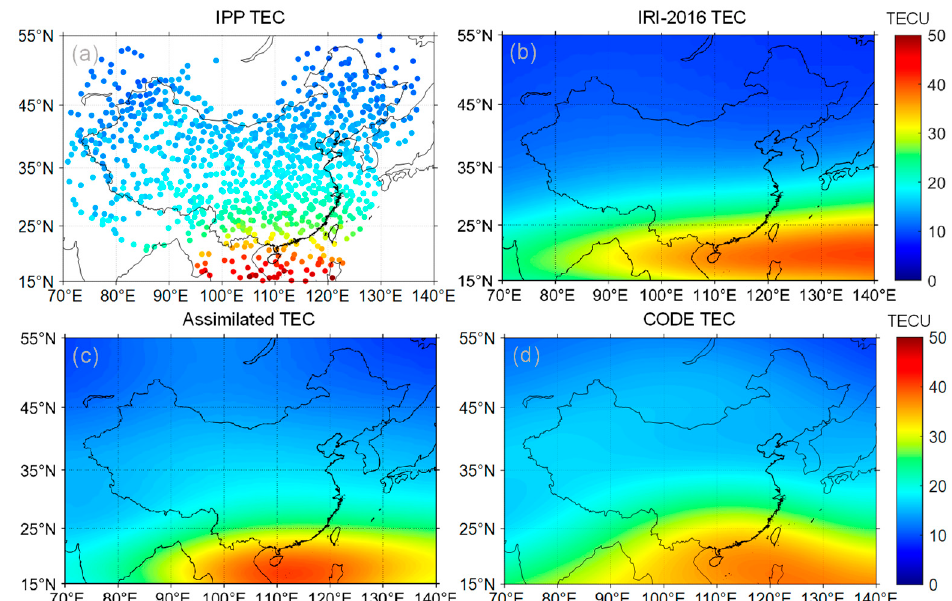
Figure 3. Comparison plot at 05:00 UT for a quiet day on 6 September 2017. ( a ) is derived from GNSS observations; ( b ) is derived from IRI-2016 model; ( c ) is derived from assimilated method of the improved ensemble Kalman filter; ( d ) is derived from CODE.